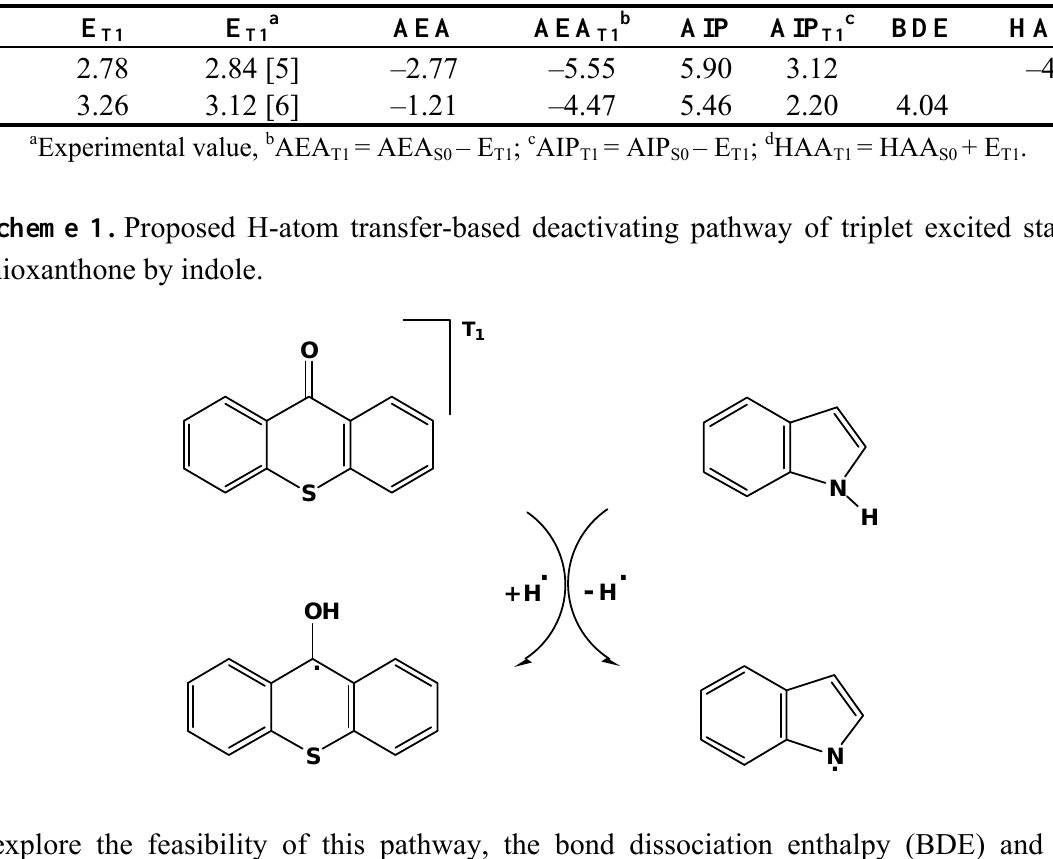
Table 1. Theoretically estimated lowest triplet excitation energy (E affinity (AEA), adiabatic ionization potential (AIP), homolytic bond dissociation enthalpy (BDE) and H-atom affinity (HAA) of thioxanthone (TX) and indole (INH) in ground (S state and triplet excited (T ) state in aqueous solution (in eV). 1 eV = 23.06 kcal/mol. 1